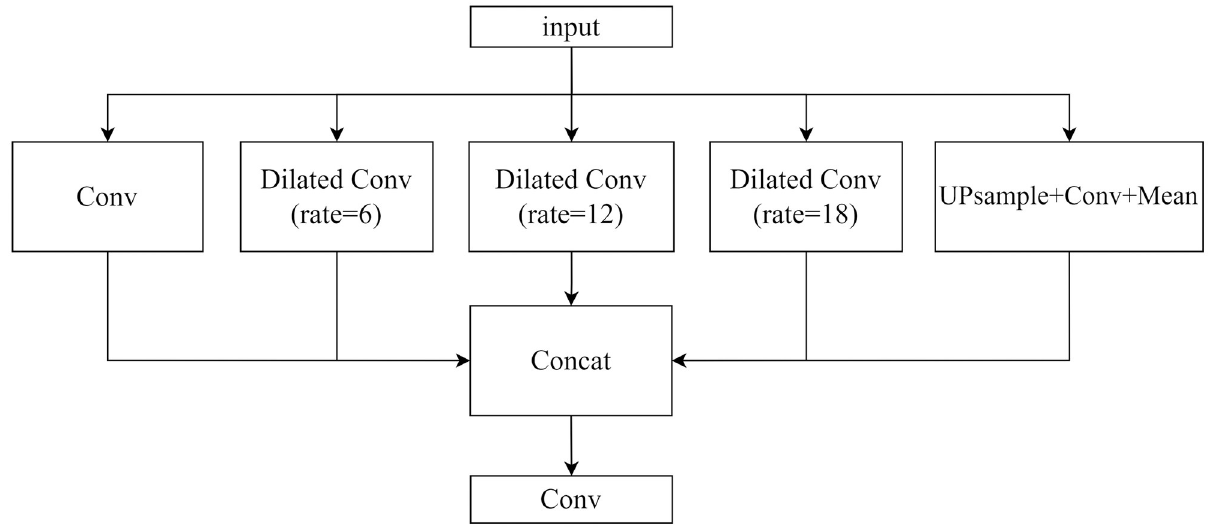
Fig 4. Schematic diagram of the structure of ASPP